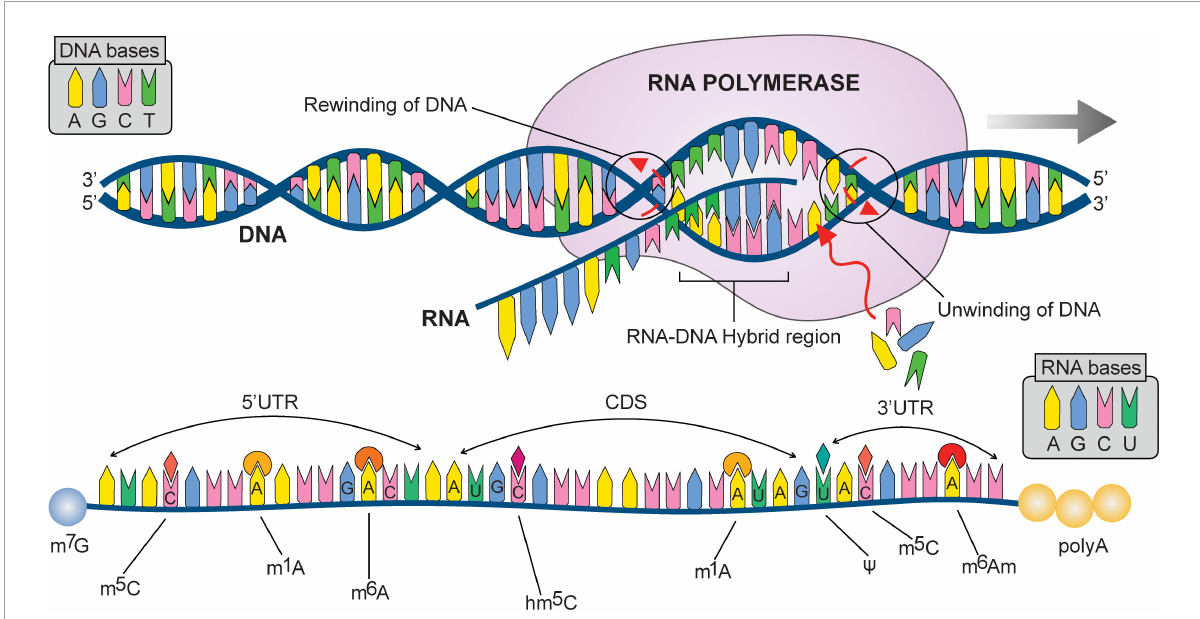
FIGURE4 Illustrate DNA to RNA transcription (followed by possible mRNA (messenger RNA) modifications at different nitrogen bases). N6-methyladenosine m 6 A; Pseudouridine ( (cid:57) ); 5-methylcytosine (m 6 C); 5-hydroxymethylcytidine (hm 6 C); N1-methyladenosine (m1A); 7-Methylguanosine (m 7 G); N6,2 (cid:48) -O-dimethyladenosine (m 6 Am). 3 (cid:48) UTR: Three prime untranslated regions; CDS: CoDing Sequence; 5 (cid:48) UTR: Five prime untranslated